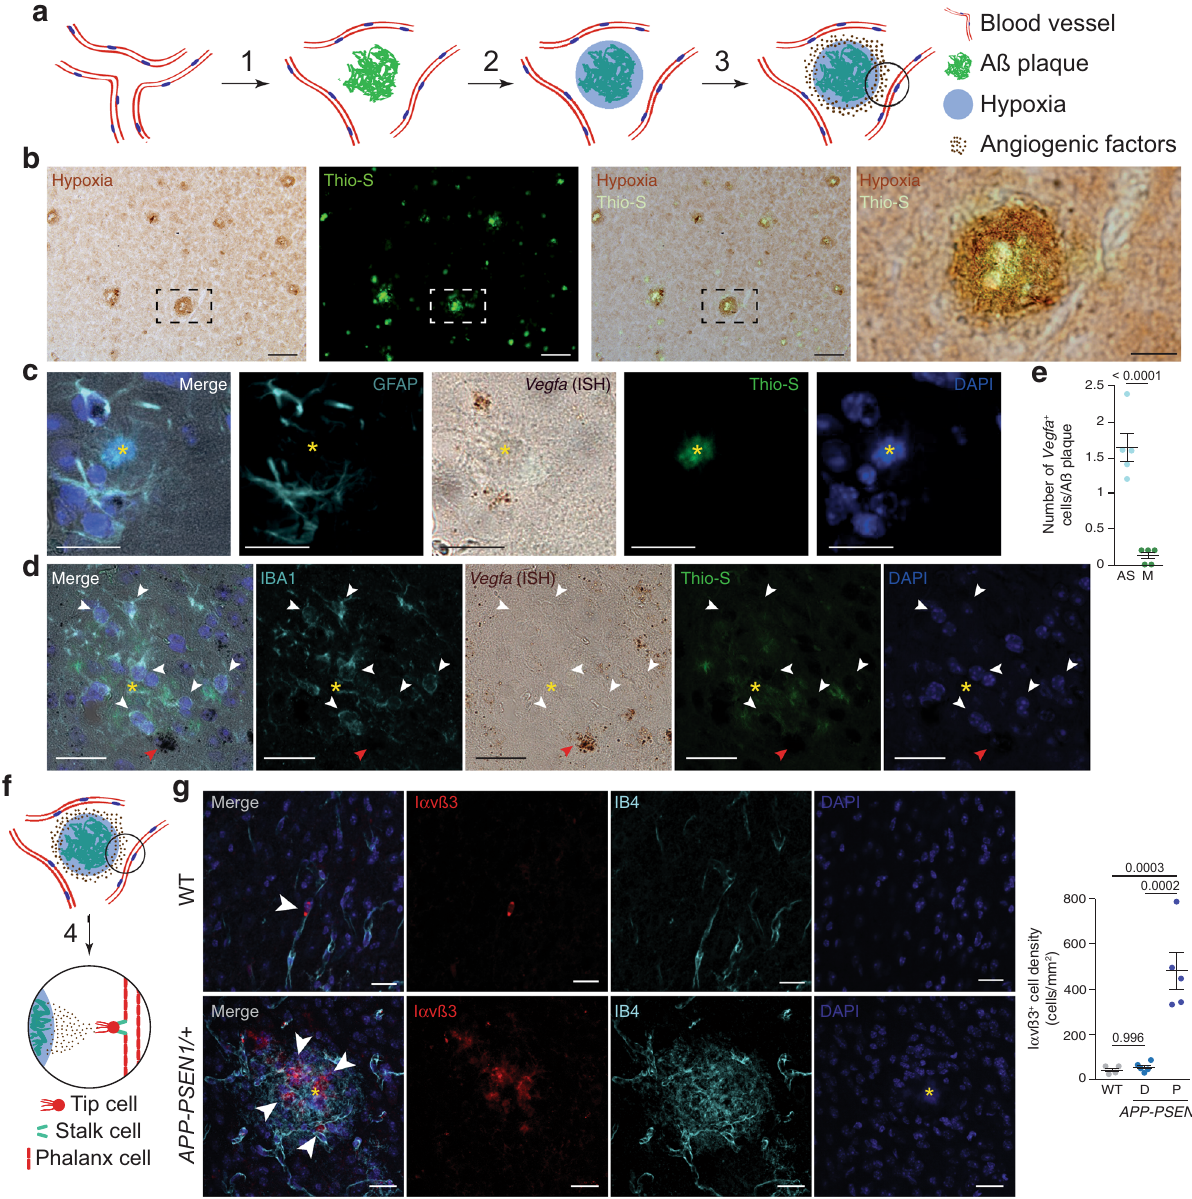
Fig. 1 Angiogenesis is concentrated around Aß plaques in AD mouse models. a Working model of the angiogenesis around Aß plaques. Aß deposition separate vessels (1) producing local hypoxia (2) and inducing angiogenic factors expression (3). b Coronal cortical sections of 14-month-old APP-PSEN1/ + mice treated with Hypoxiprobe (Pimonidazole HCl; 60mg/kg i.p.; 45min) showing hypoxia (brown, immunoperoxidase, DAB) in the vicinity of Aß plaques (green, Thio fl avin-S staining – Thio-S – ). The dashed square box is shown in the rightest panel. Scale bar = 100 and 25 µ m, respectively, in low and high magni fi cation images. c , d Vegfa is mainly expressed by astrocytes around Aß plaques in 8-month-old APP-PSEN1/ + mice. Aß plaques are indicated by a yellow asterisk. Cortical confocal XY images stained with astrocytic (GFAP; cyan; c ), Vegfa (in situ hybridization, ISH; brown), Aß (Thio-S; green), microglial (IBA1; cyan, d ), and nuclear (DAPI; blue) markers. White arrowheads indicate microglial cells without Vegfa expression and red arrowheads point to a non-microglial Vegfa - expressing cell ( d ). Scale bars ( c , d ) = 20 µ m. e Quanti fi cation of the number of astrocytes (AS) and microglia (M) expressing Vegfa mRNA per Aß plaque. Mean±SEM. n = 5 mice (5 Aß plaques per mice); Student ’ s t -test. f VEGF differentiates phalanx cells to tip cells that extrude from the vessel and stalk cells that will produce the new capillary (4). g A cortical mouse brain area stained with angiogenic endothelial (Integrin α vß3 – I α vß3 – ; red), microglial (IBA1; green), endothelial (IB4; white), and nuclear (DAPI; blue) markers. Scale bar = 20 µ m. Right graph, quanti fi cation of the I α vß3 + cell density in 8-month-old wild- type (WT) and APP-PSEN1/ + mice. Mean±SEM. n = 4 WT and 5 APP-PSEN1/ + mice; ANOVA, post hoc Tukey ’ s